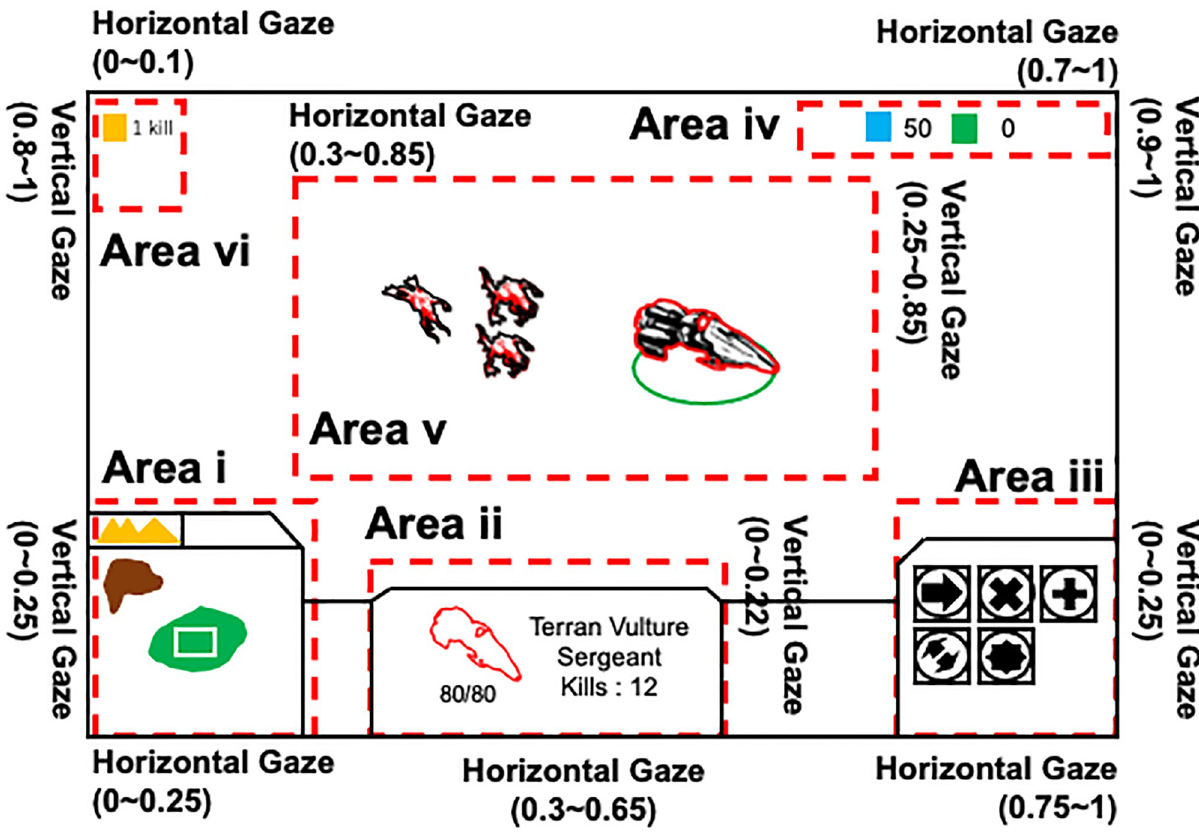
Fig 2. StarCraft main play screen. Dashed lines indicate six areas. Values in parentheses show the relative coordinates of each area normalized to monitor size, 0 to 1 in both horizontal and vertical directions. Area i: a mini-map which shows a bird’s-eye view of all play Zones. When a critical event such as an attack from the enemy occurs in a certain Zone, the Zone blinks to inform the player that an event has occurred. Area ii: information about the number of destroyed enemy units, and remaining strength of the commander unit which is operated by the player. Area iii: the function(s) of a selected unit or building. Area iv: the number of resources. Area v: the play area which is a part of the selected Zone. Area vi: the total score amassed thus far by destroying enemy units. The various kinds of units, buildings, and Zones are described in the main